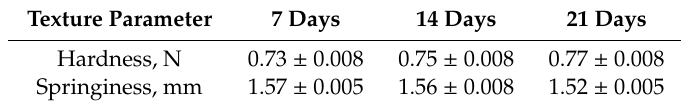
Table 1. Texture Profile Analysis of beetroot dried chips enriched with Lb. plantarum BL3.